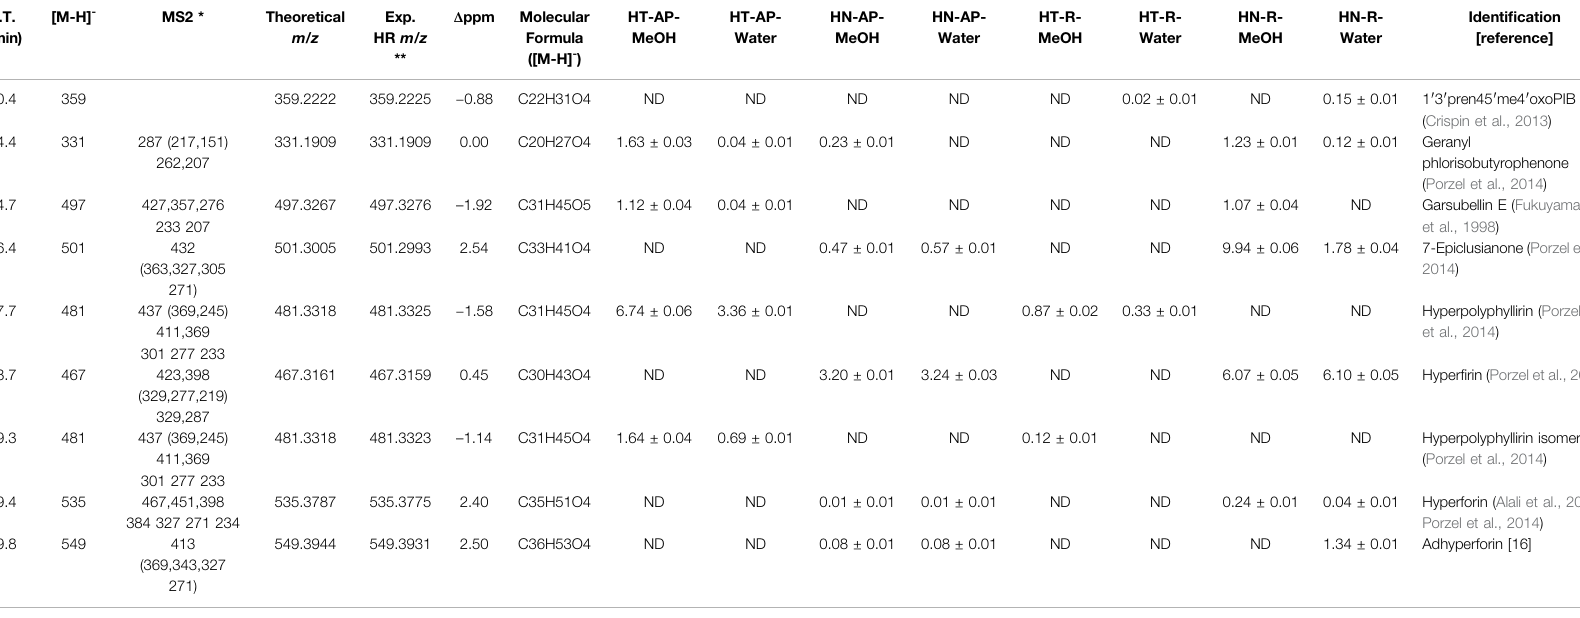
HT-AP-MeOH: H. triquetrifolium aerial parts, methanol extract; HT-AP-Water: H. triquetrifolium aerial parts, water extract; HT-R-MeOH: H. triquetrifolium root, methanol extract; HT-R-Water: H. triquetrifolium root, water extract; HN-AP- MeOH: H. neurocalycinum aerial parts, methanol extract; HN-AP-Water: H. neurocalycinum aerial parts, water extract; HN-R-MeOH: H. neurocalycinum root, methanol extract; HN-R-Water: H. neurocalycinum root, water extract; ND: not detected. *: fragments in bold indicate the source of the MS3 fragments, reported in brackets; **: experimental values obtained from LC-QTOF analysis.Quantitative data of all the extracts are also